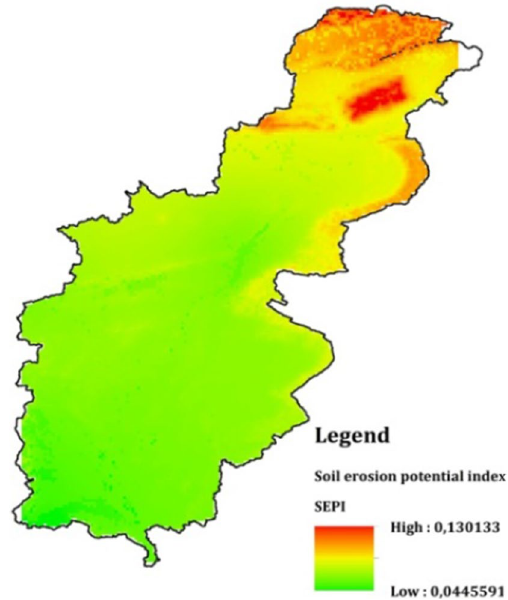
Fig. 9 Soil erosion index